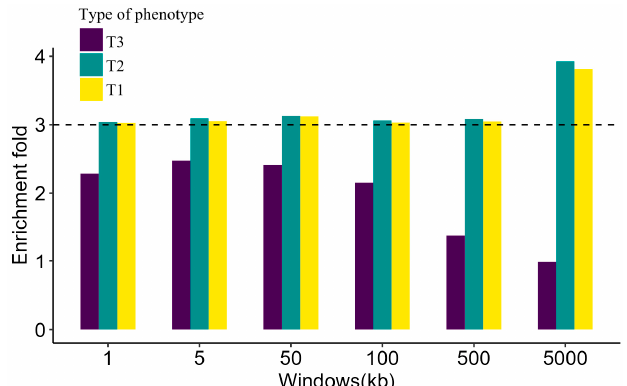
Figure 3. Comparison of different LD window settings for the LDAK model. The estimated enrich- ment of different LD window settings for the LDAK model integrated with “Functional subset”. The different colors and dotted line are explained as in Figure 1.